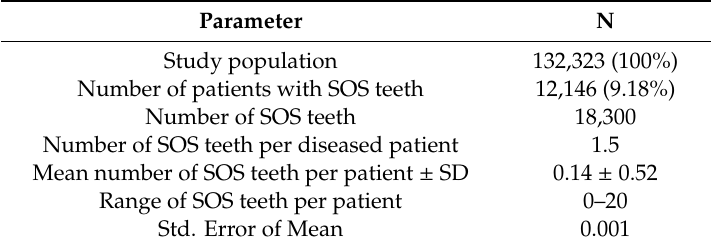
Table 1. Descriptive statistics of SOS teeth among the study